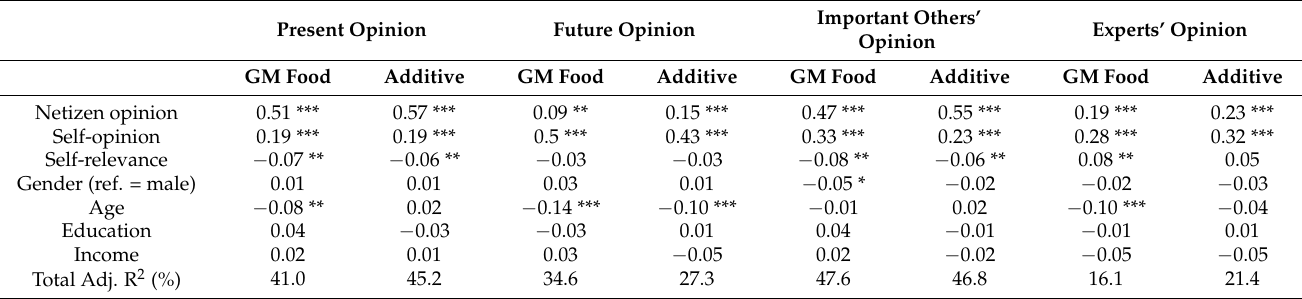
Table 3. Factors influencing opinion